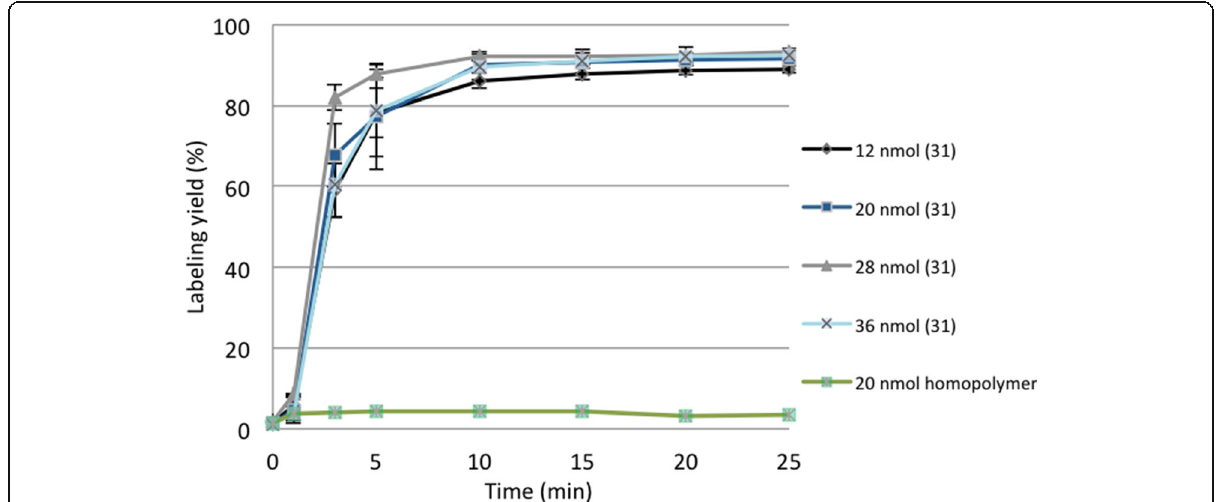
Fig. 3 Time course of 68 Ga-complex formation with varying amounts of DOTA-HPMA conjugate 31 and polymer (20 nmol) not modified with DOTA as a control